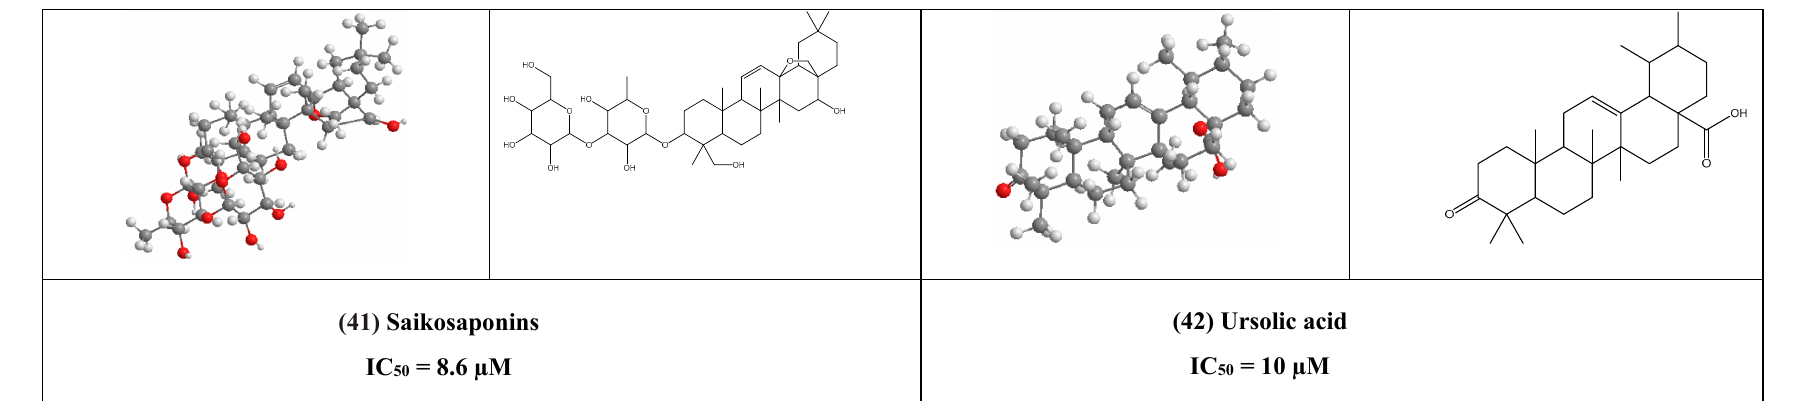
Figure 6. The 2D and 3D chemical structures of other antiviral